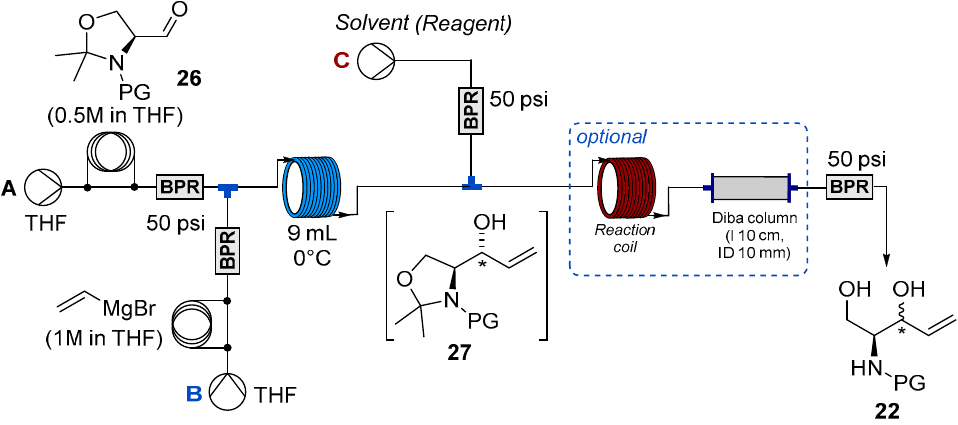
Scheme 7. Optimisation of the flow addition/deprotection reaction